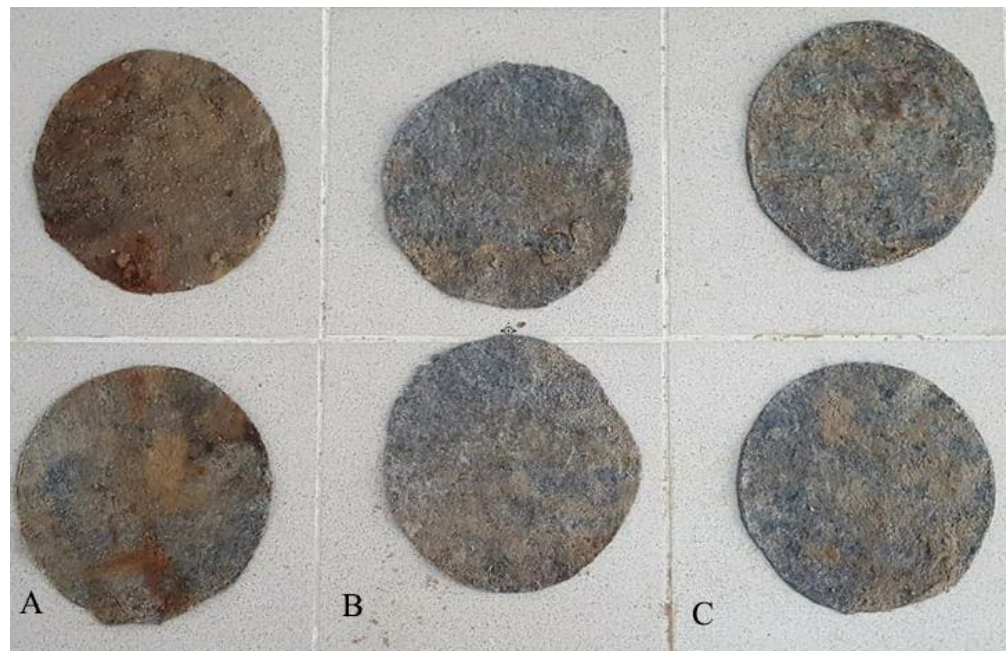
Figure 6. Samples of nonwoven geotextile WD-3 from the drainage of the Piaski-Szczygliczka Dam; from A, B and C sampling zones.